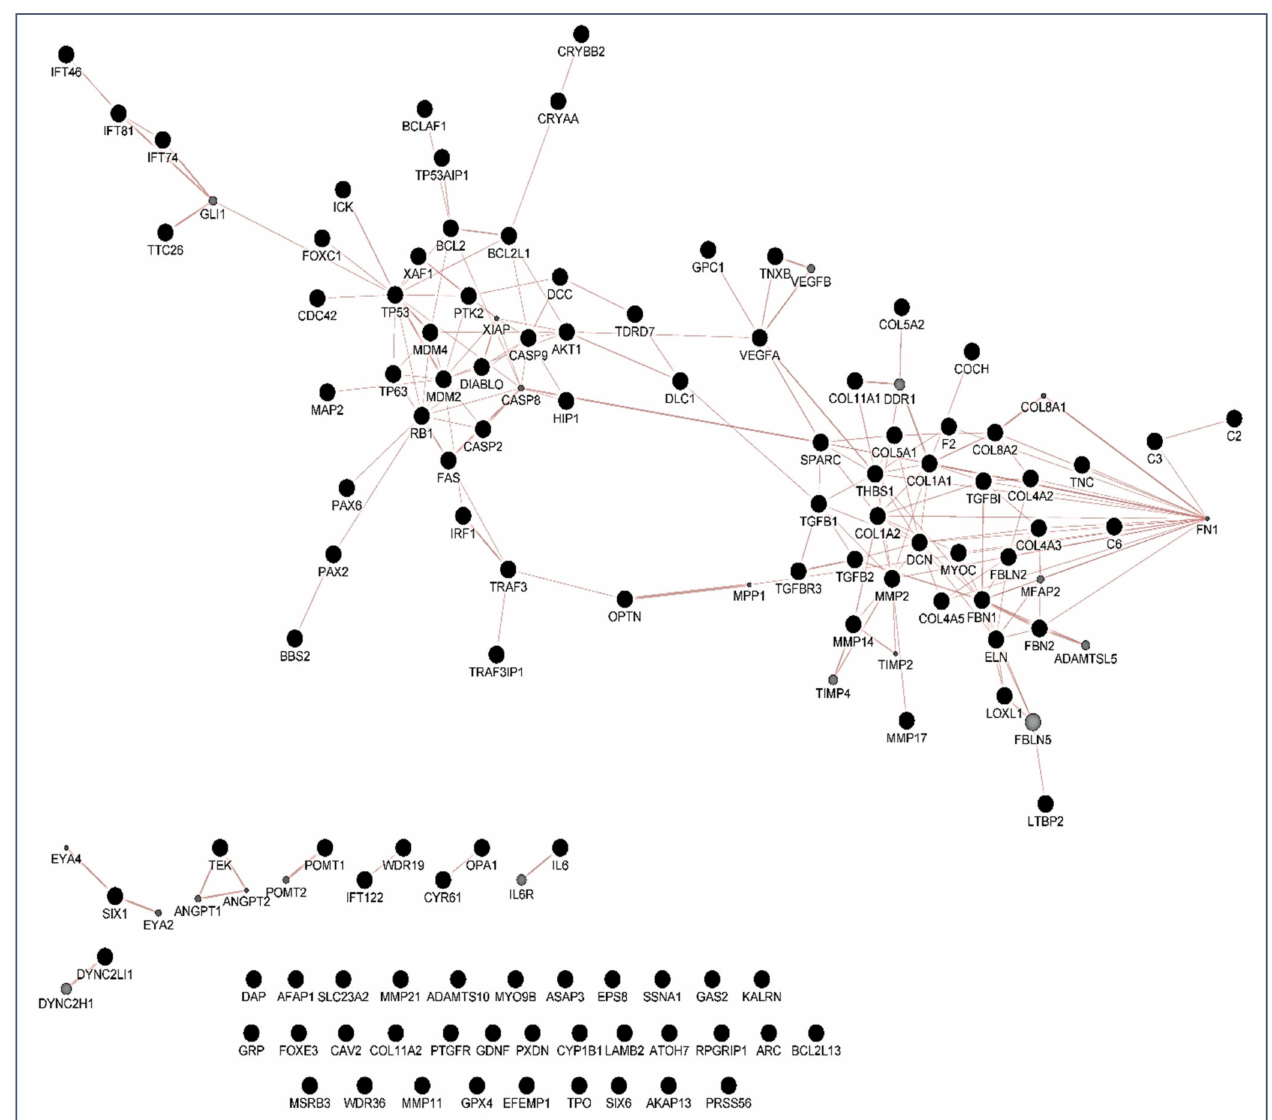
Figure 5. Physical interaction map created with GeneMania. Black nodes are genes present in the original gene list, grey nodes are additional genes that are found interacting with the original ones in a protein–protein interaction study. The genes FOXC1, CASPs, MAP2, TP53, BCL2, DIABLO, IL6, TGF β , OPTN, MMPs, among others, were identified. Size of grey nodes indicate the likelihood of physical interaction (score), and thicker lines (edges) indicate a stronger interaction. Data are collected from primary studies from protein interaction databases including BioGRID and